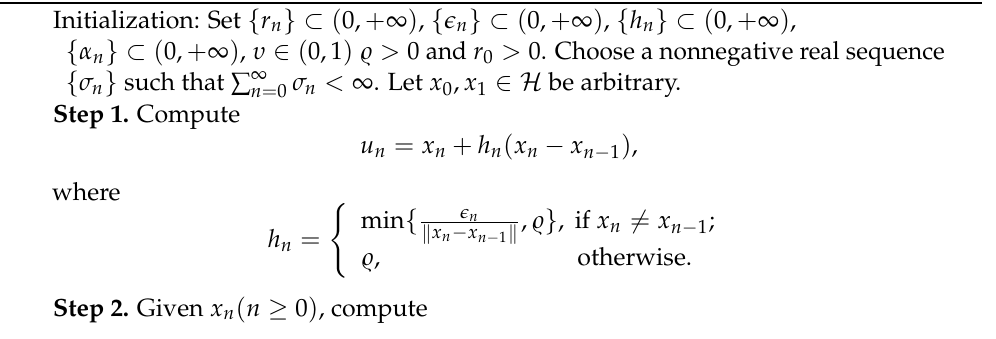
Algorithm 6 The inertial Tseng extragradient method with regularization for the mixed equilibrium